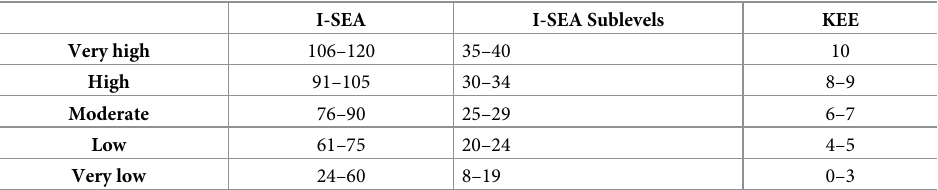
Table 1. Scales of acceptance and understanding of the TE proposed by Kuschmierz et al